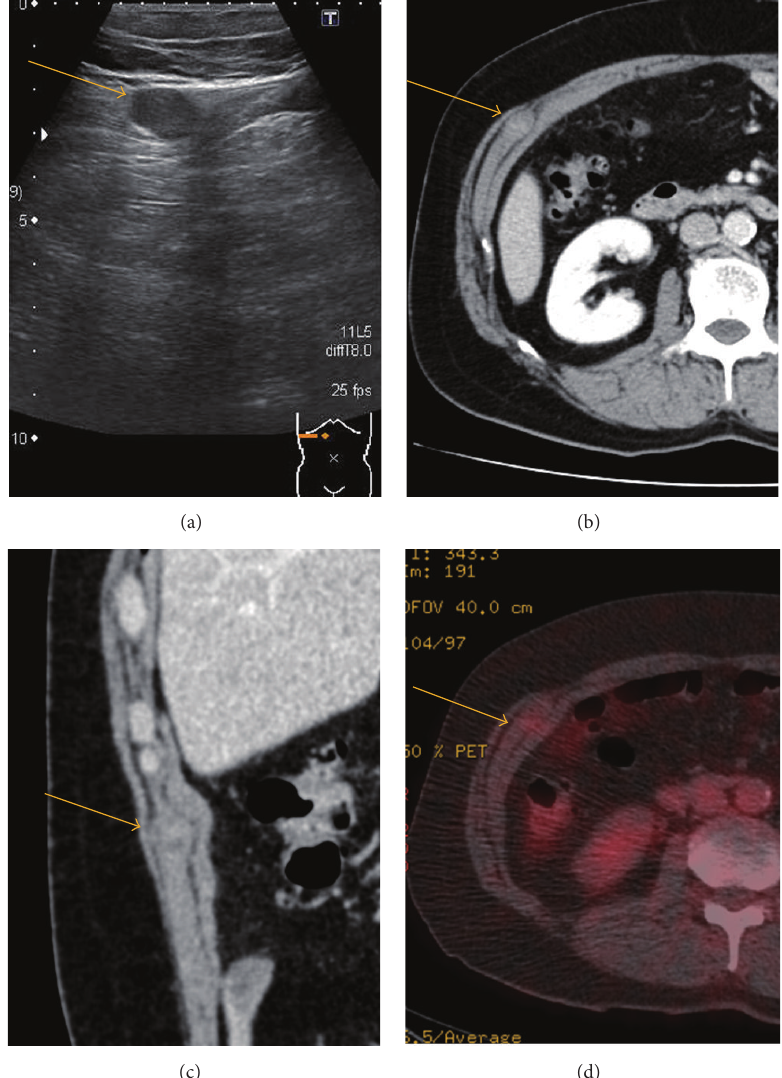
Figure 1: (a) US shows a well-demarcated hypoechoic mass in the abdomen. (b) Axial view and (c) coronal view of the CT abdomen with intravenous contrast. The mass shows a heterogeneous density in the internal abdominal oblique muscle. (d) FDG-PET demonstrated low FDG uptake in the tumor. The maximum SUV of the tumor was